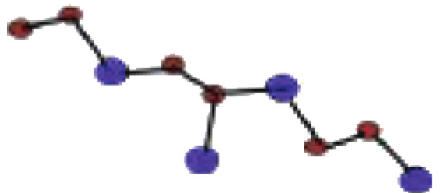
Figure 5: One unit of Si